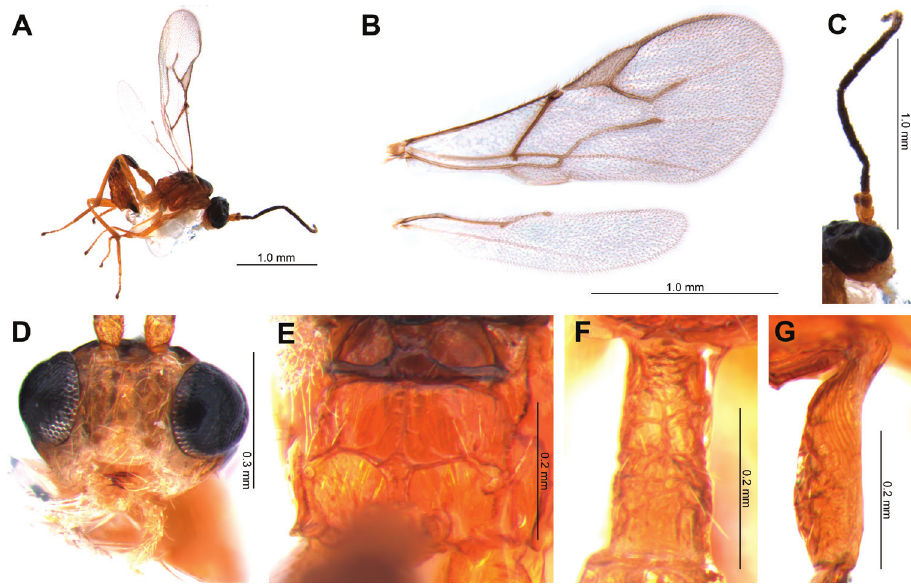
Figure 2. Aphidius longicarpus Kim & Tomanović, sp. nov., female A body B wing C antennae D head E propodeum F dorsal view of petiole G lateral view of